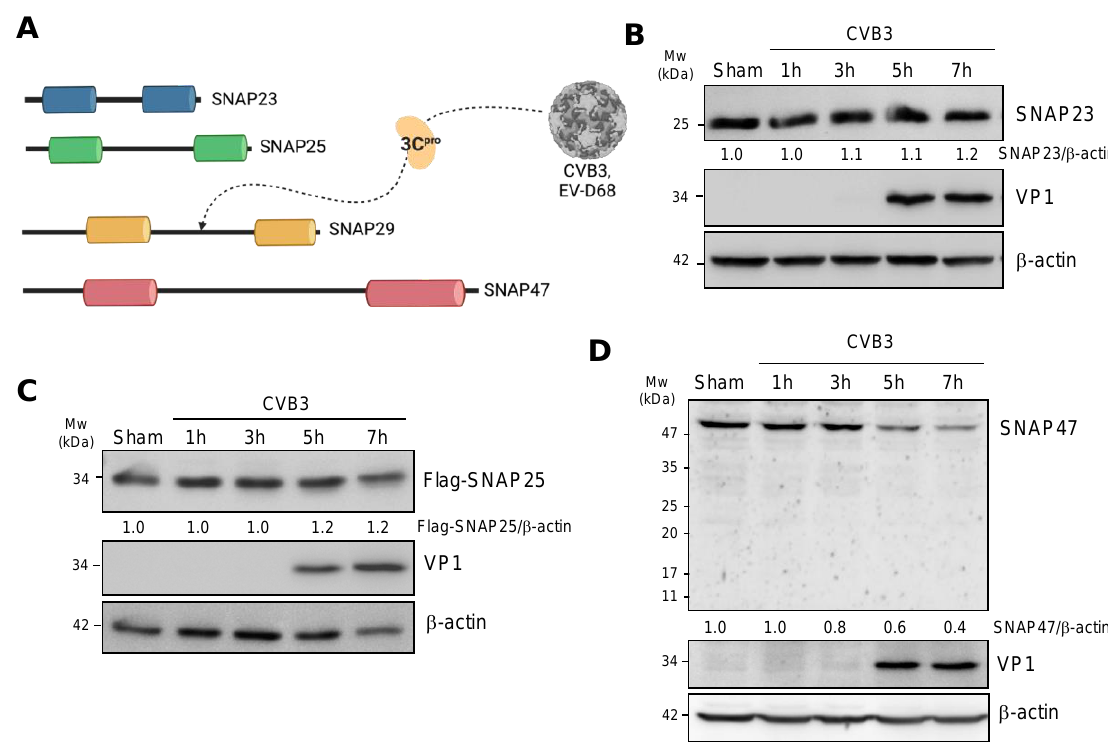
Figure 1. SNAP47 is downregulated following CVB3 infection. ( A ) Schematic diagram illustrating the homologous structure of SNAP23, SNAP25, SNAP29, and SNAP47. Each SNARE carries two homologous SNARE domains. SNAP29 was previously reported to be cleaved by viral proteinase 3C (3C pro ). ( B – D ) HeLa cells ( B , D ) or HeLa cells transfected with Flag-SNAP25 ( C ) were infected with CVB3 at an MOI of 10 for indicated timepoints. Western blot analysis was conducted to examine the protein levels of endogenous SNAP23 ( B ), exogenous Flag-SNAP25 ( C ), endogenous SNAP47 ( D ), viral capsid protein VP1, and β -actin (loading control). Densitometry was performed and the ratio of SNAPs over β -actin is presented underneath the